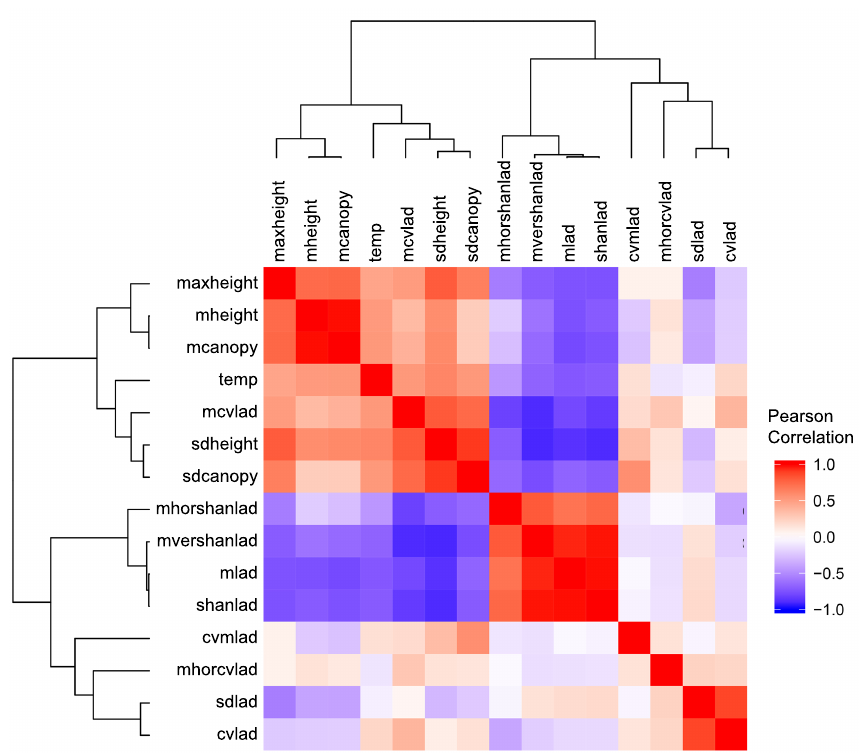
Figure 4. Correlation matrix heatmap and dendrogram representing associations among metrics. The length of the dendrogram branches represents the distance between variables or clusters of variables calculated from bivariate Pearson